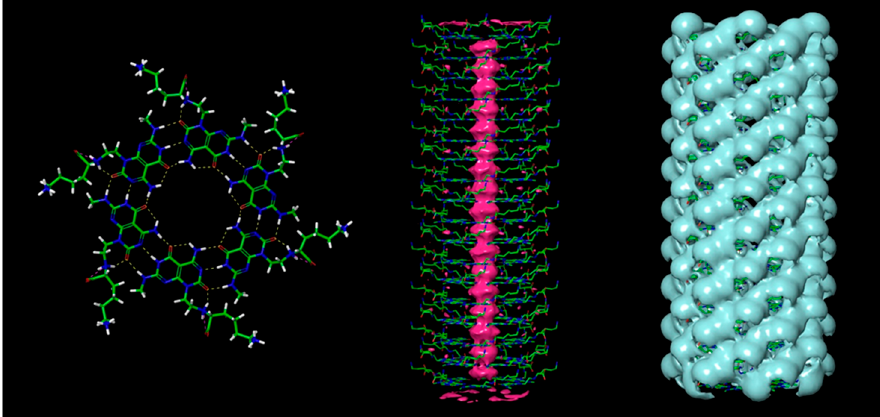
Figure 2. One type of Janus-based nanotubes (JBNTs) developed by the Dr. Yupeng Chen, et al. Image taken with permission.